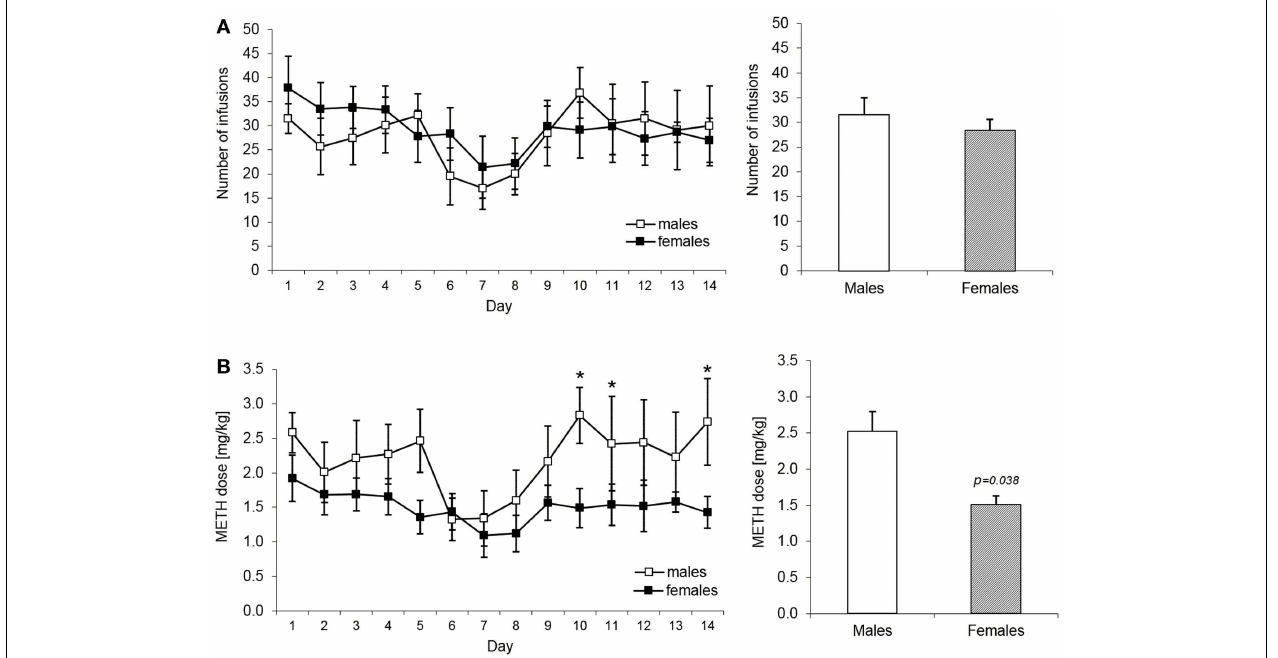
the mean dose in milligram per kilogram of METH self-administered by male ( n = 6) and female ( n = 6) rats. The groups start to differ significantly from the day 10 with t -test results: day 10 ( p = 0.021), day 11 ( p = 0.049), and day 14 ( p = 0.048). The bar graph shows the mean number of infusions over the last